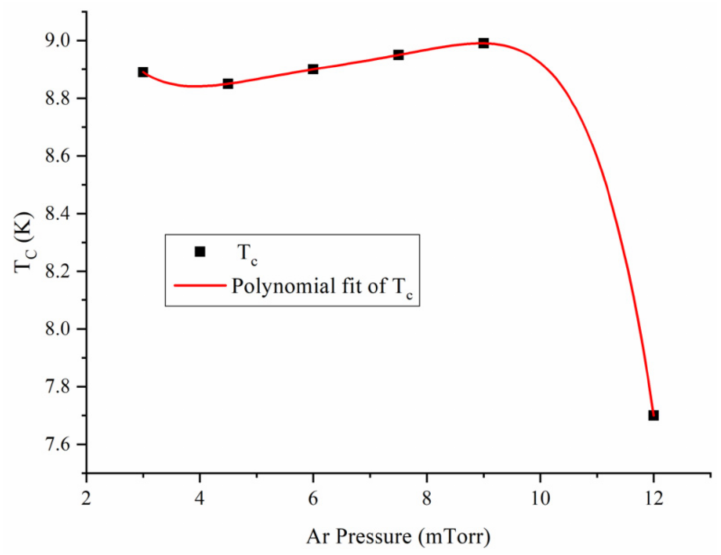
Figure 2. The superconducting transition temperature of Nb films versus Ar pressure.